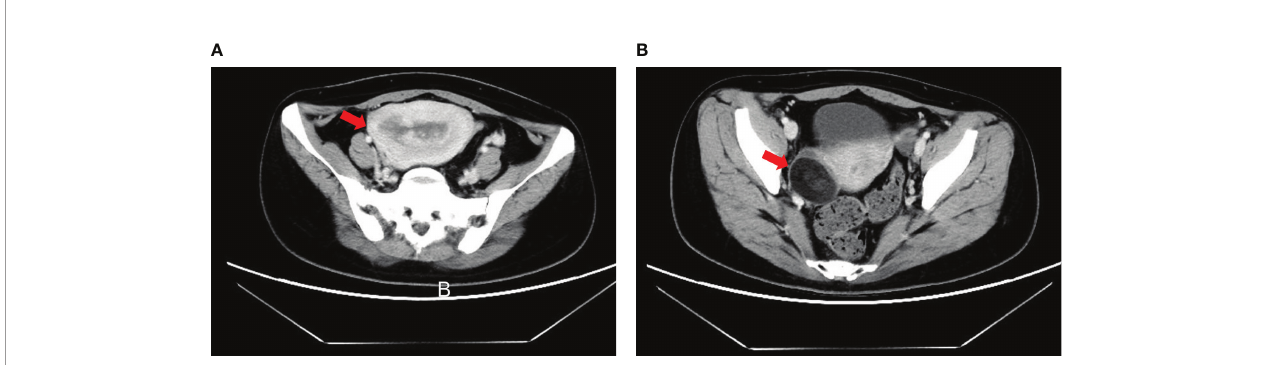
FIGURE 1 | Computed tomography (CT) scan of patient with endometrial YST preoperatively. (A) Enlarged uterus equal to pregnancy for 2 months accompanied by occupancy in the uterus cavity; (B) A 3-cm mass of uneven density in the right